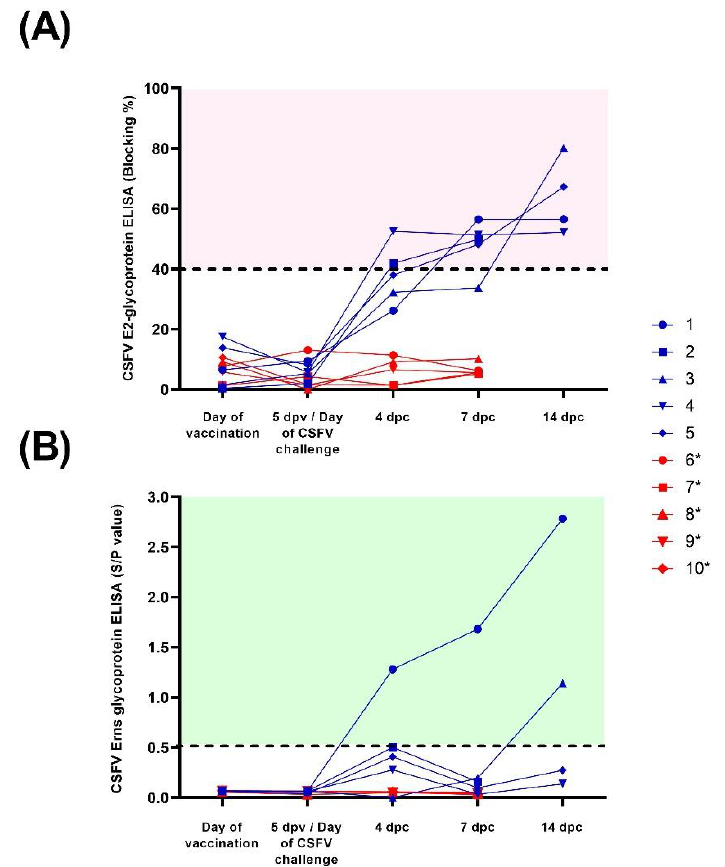
Figure 2. Antibody response after CSFV vaccination and challenge. Sera samples from FlagT4G- vaccinated (blue lines and symbols) and unvaccinated (red lines and symbols) animals were collected and evaluated for antibodies against the E2 ( A ) and E rns ( B ) glycoproteins. For the E2 ELISA test, results are expressed as blocking percentage, and values above 40% (red-shaded area) were considered positive. In the case of anti-E rns antibodies, results were expressed as the sample/positive value with samples above 0.5 (green shaded area) determined to be positive. * Euthanized for animal welfare